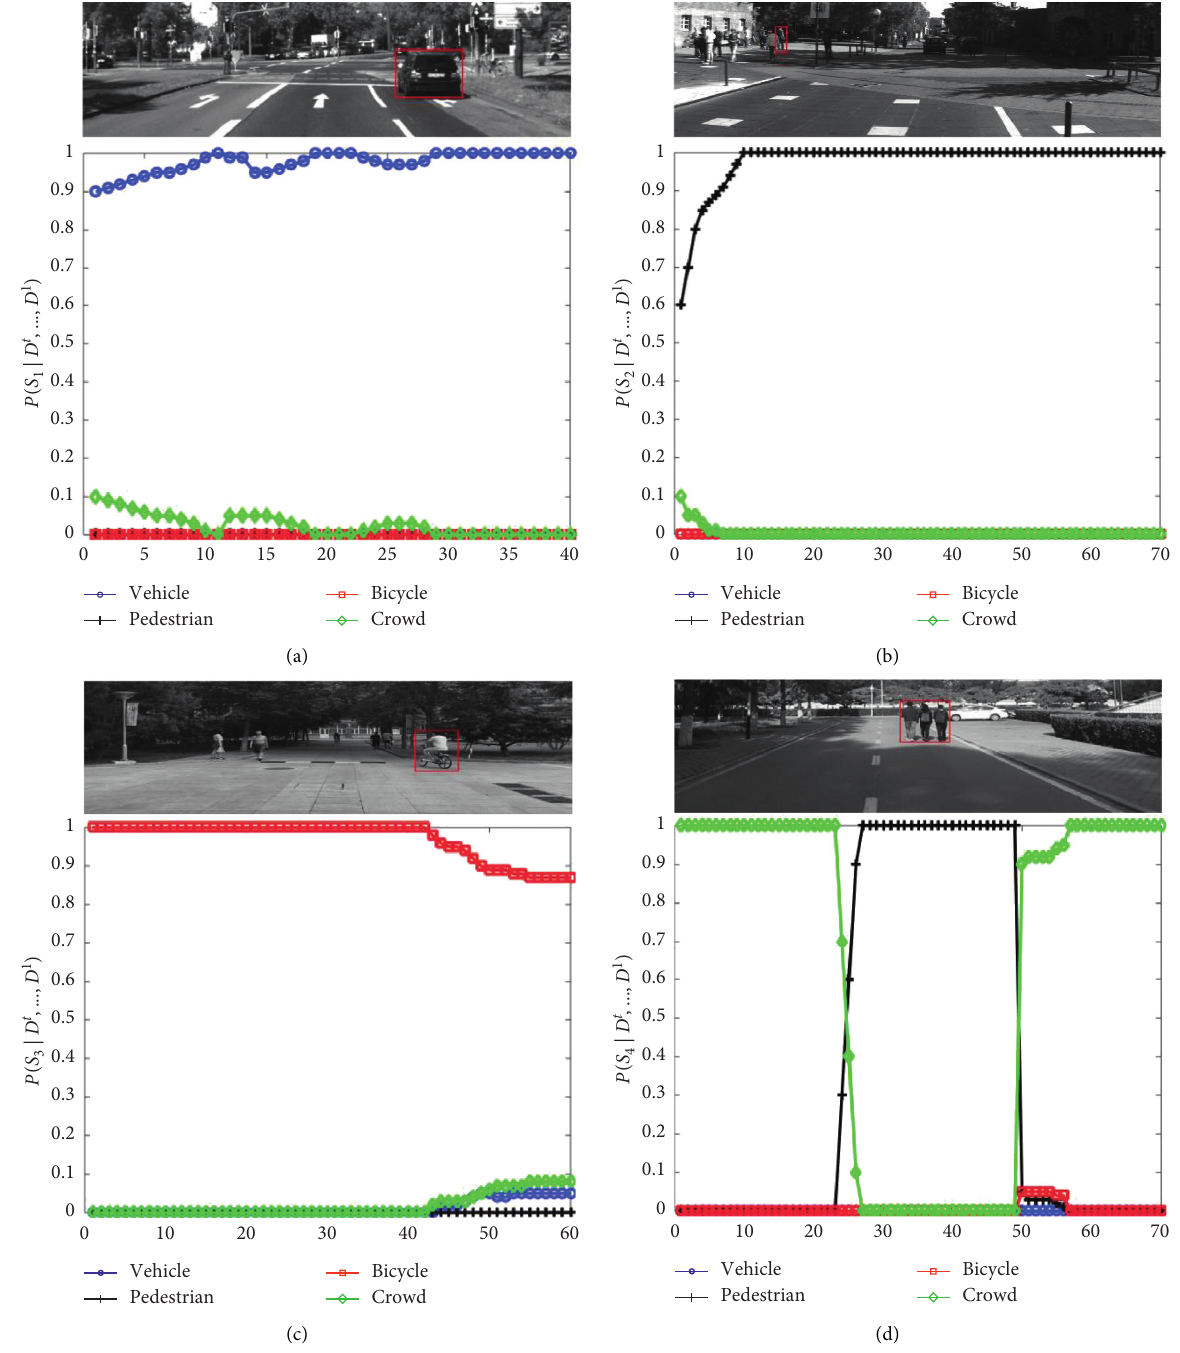
Figure 6: The variation of posterior probability that point cloud of moving object belongs to each category S (b) pedestrian, (c) bicycle, and (d)